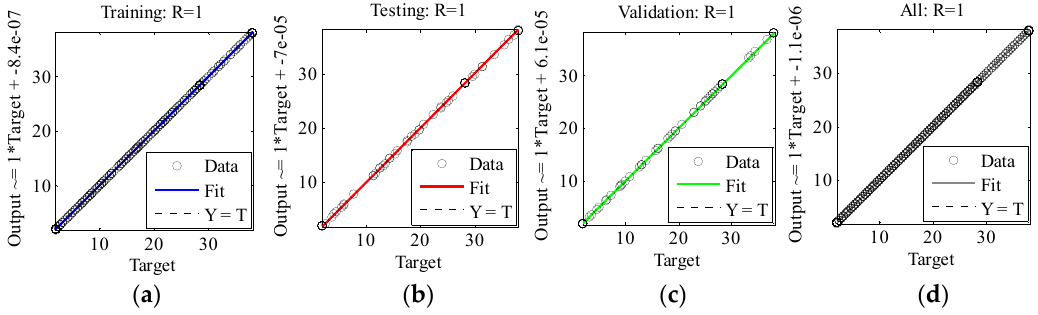
Figure 15. Regression coefficient (R) of the ANN algorithm for ( a ) training, ( b ) testing, ( c ) validation, and ( d ) all data for the LOS environments.